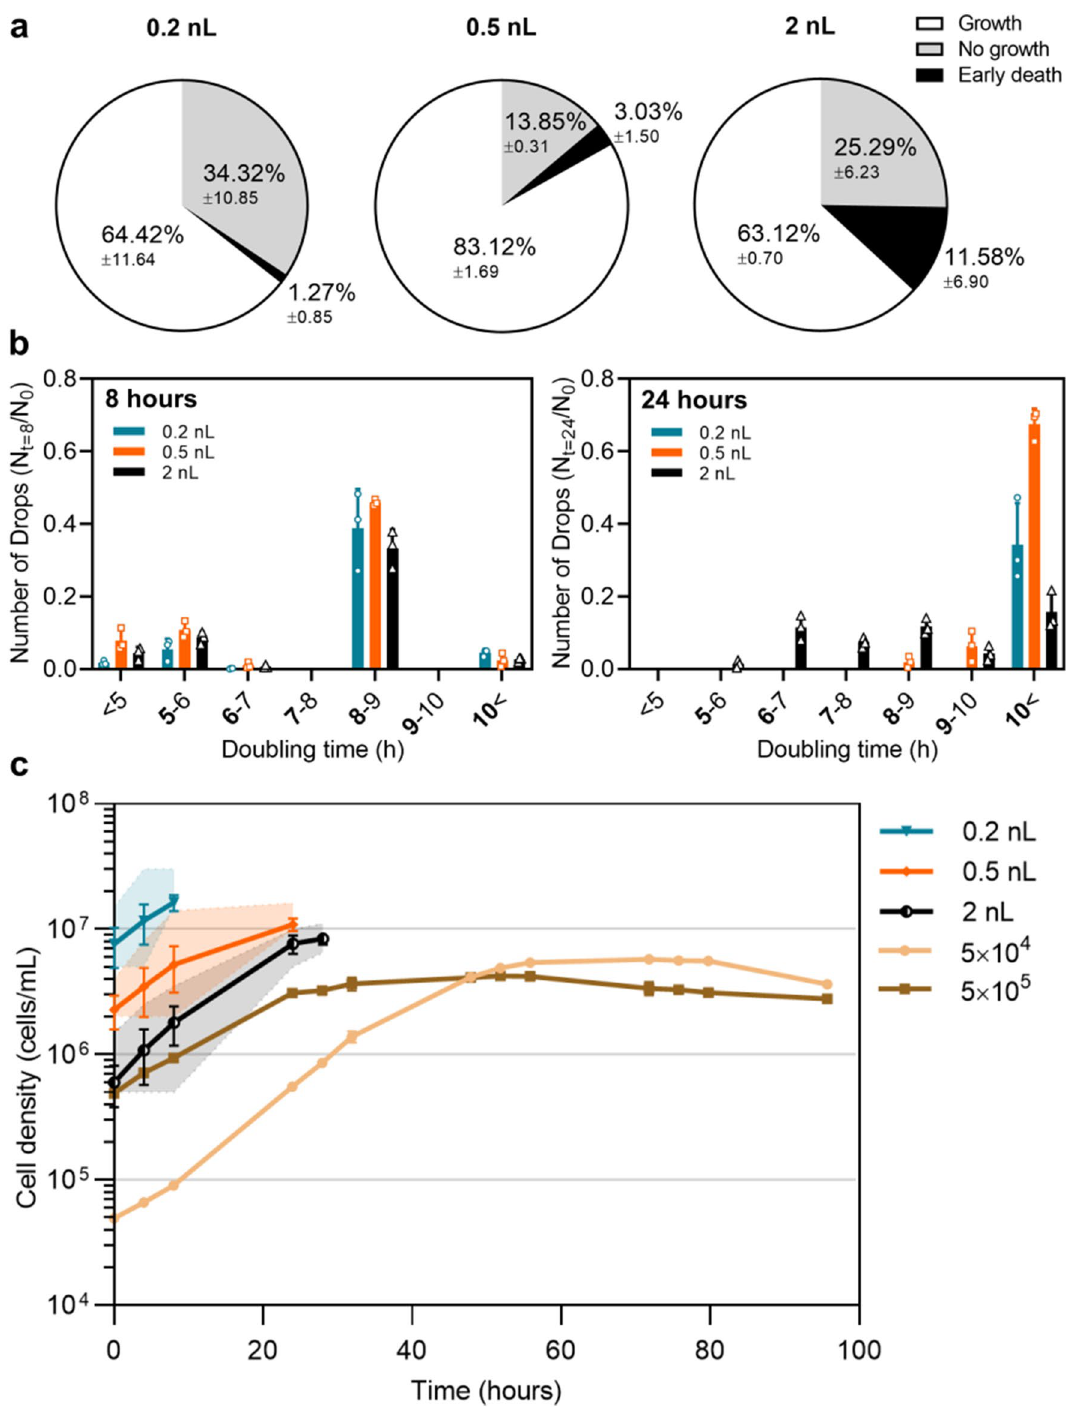
Figure 4. Growth variabilities within drop populations. ( a ) Divisions of the total populations in three main behaviors; normal growth (white), survival for more than 8 h without division (grey) and early death occurring before 8 h (black) in 0.2 nL, 0.5 nL and 2 nL drops. ( b ) Comparison of doubling times at 8 h and 24 h between 0.2nL drops (blue), 0.5nL drops (orange) and 2 nL drops (black). Doubling times represented by bold values are included in the respective group. ( c ) Comparison of growth curves between drop cultivation (blue, orange and black lines) and standard cultivation (brown lines) techniques. Droplet growth curves represent the fastest growing populations in 0.2 nL, 0.5 nL and 2 nL droplets. The shaded areas show the lower and upper limits of the cell numbers. Standard growth curves are initiated from respectively 5 and ( b ) are presented as mean values of biological triplicates ±SD. Results in ( c ) are presented as mean values ±SD of biological or technical triplicates for respectively drop- and standard cultivation